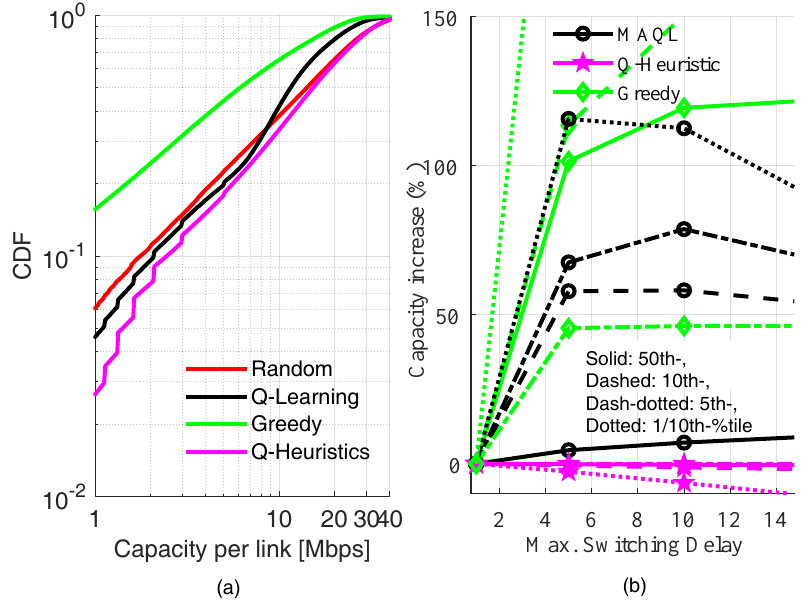
Figure 10. Different percentiles of the capacity per inXS versus maximum switching delay. ( a ) CDF with no switching delay; ( b ) Effect of switching